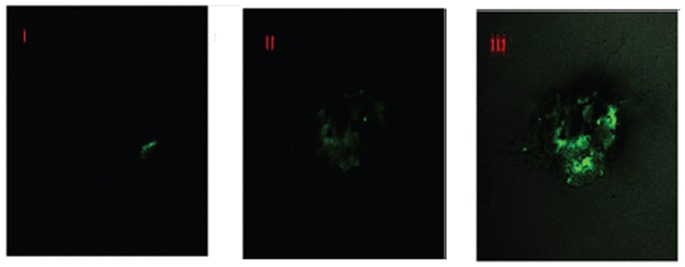
Andrographolide nanoparticles uptake in macrophage cells.Fluorescence image. FITC-loaded PLGA nanoparticles (FAGnps) were used to study the cellular uptake of AGnps in peritoneal macrophage cells as the amastigote cells reside within the phagolysosomes of macrophages. 4×105 macrophage cells/well in three bathes were seeded with FAGnps (0.5 mg/ml) and incubated in CO2 incubator at 37°C, for (I), 15 minutes; (II), 30 minutes; and (III), 60 minutes. Samples were withdrawn after these time intervals and observed in FITC channel under fluorescence microscope. The prepared nanoparticles showed considerable cellular internalization within 1 hour of incubation and insignificant internalization within 15 minutes period. Cellular internalization of FAGnps only took place in living cells. This figure represented time dependent uptake of FAGnps.